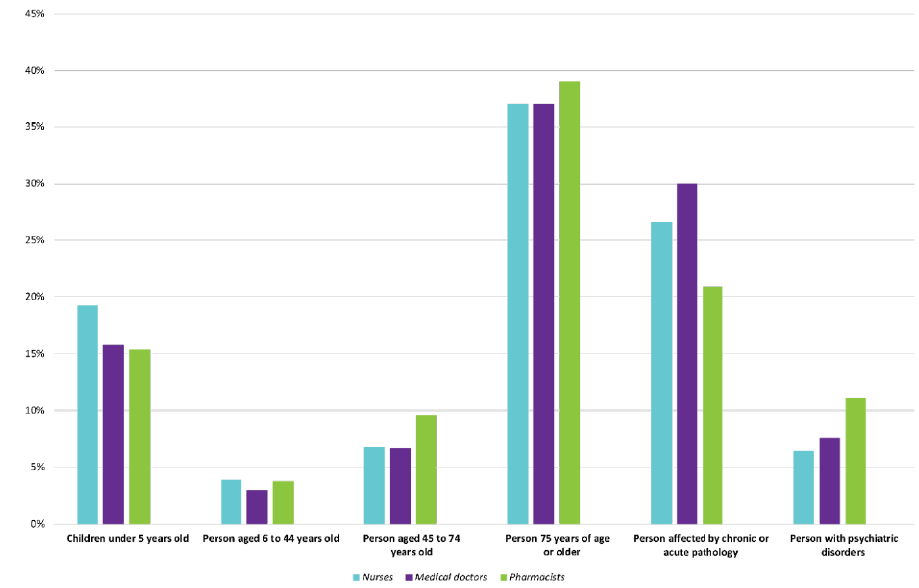
Figure 8. Weights of Vulnerability Factors by Medical Professions.